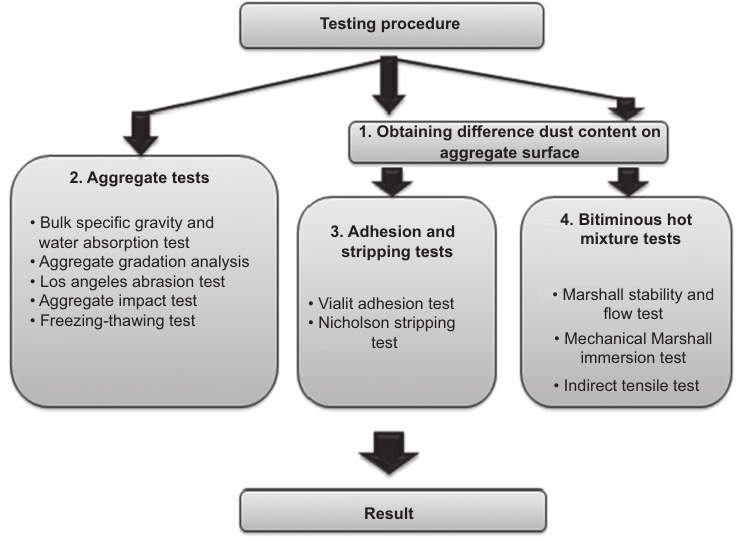
Figure 1 Flowchart of the testing procedure.